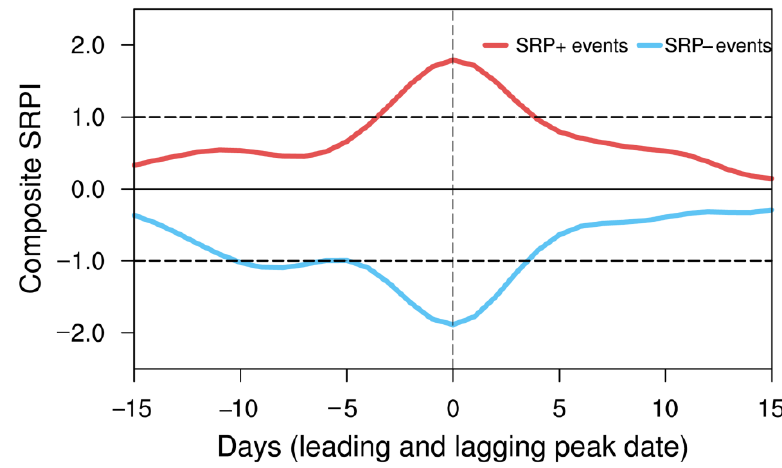
Figure 2. Composite indices of SRP+ (red line) and SRP − (blue line) events from day − 15 to day 15. The numbers on the abscissa represent the days leading (negative) and lagging (positive) the peak date of SRP events.